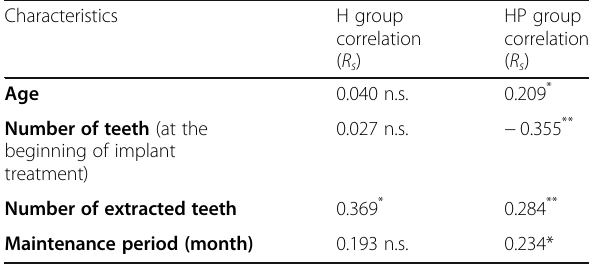
Table 5 Correlations between PPD and characteristics Characteristics H group